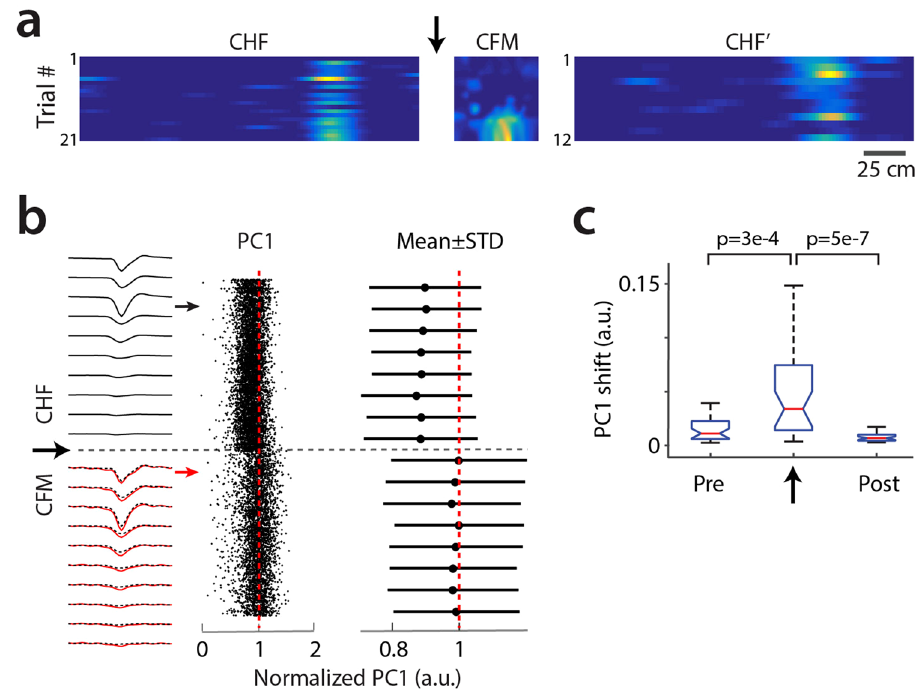
Figure 6. Impact of connector plugging/unplugging on unit stability. ( a) An example of one cell recorded first in chronic head-fixed setting (CHF), then in chronic freely moving setting (CFM) following the unplugging of optical connectors and the unplugging/plugging of the recording head-stage, and then back in the chronic head-fixed setting (CHF’). The arrow indicates the session transition considered for the analyses shown in b and c. ( b) Temporal evolution of spike waveforms for one cell example. Left, average spike waveforms for 2 ′ time windows taken during CHF (black) and CFM (red) recording sessions. The two waveforms are overlaid (red line and black dash line) to facilitate comparison. Middle, first principal component (PC1) of individual spikes. Right, means ± standard deviations of PC1 for consecutive 2 ′ windows. PC1 values are normalized by the maximum of the means. ( c ) Population median (red), quartiles (blue) and edges (black) for cells’ shifts in PC1 values between the two consecutive 2 ′ time windows preceding (pre), within (arrow), and following (post) session transition. (Kruskal-Wallis test, n = 33